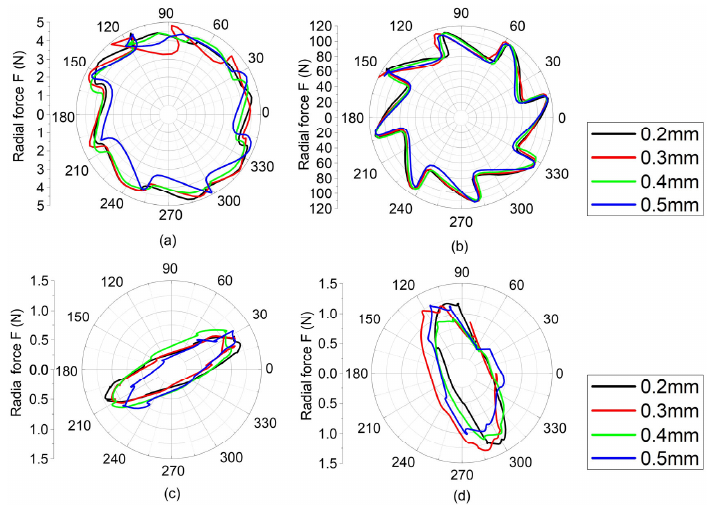
Figure 12. Radial force of different flow parts in pump under different TCs: ( a ) radial force of inducer hub, ( b ) radial force of inlet pipe, ( c ) impeller radial force, ( d ) radial force of short blade of